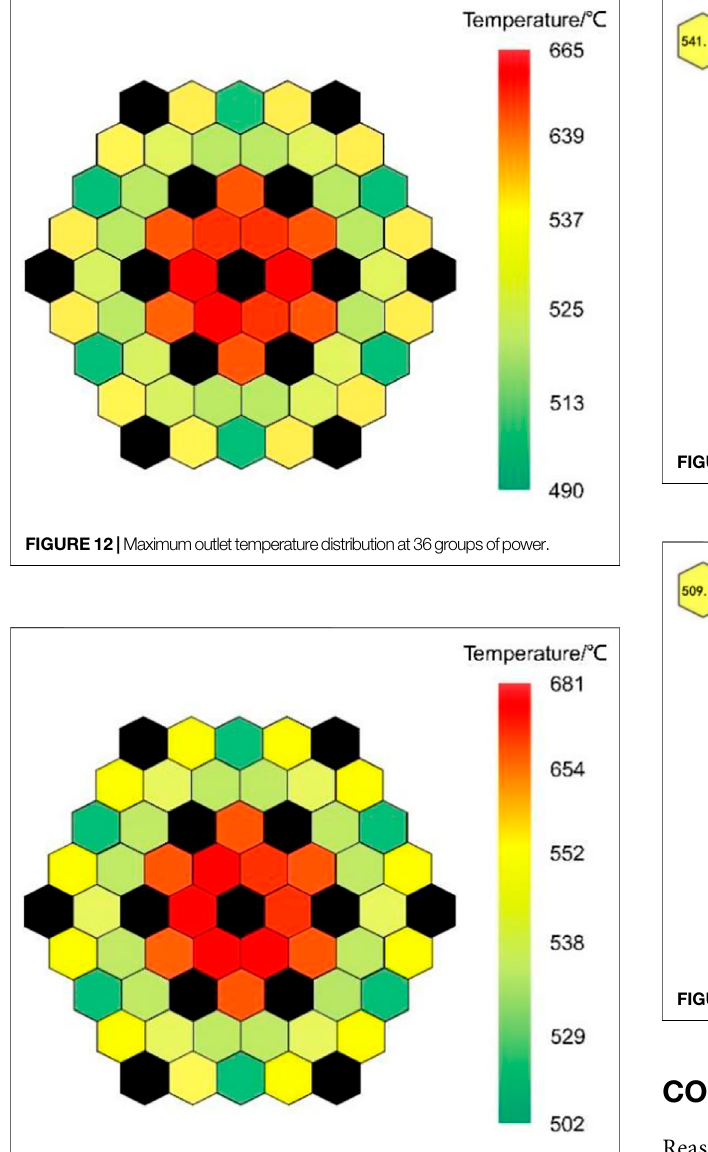
FIGURE 13 | Sub-channel program simulates and calculates the maximum outlet temperature of each component.